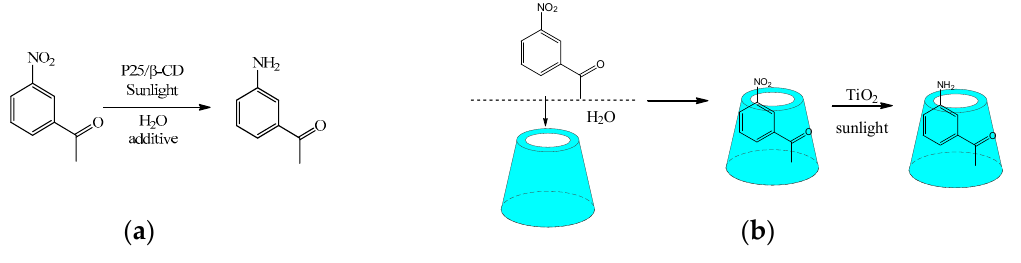
Scheme 8. ( a ) The photoreduction of 3-nitroacetophenone catalyzed by β -CD-TiO 2 ; ( b ) the mechanism of the photoreduction of 3-nitroacetophenone catalyzed by β -CD-TiO 2 .